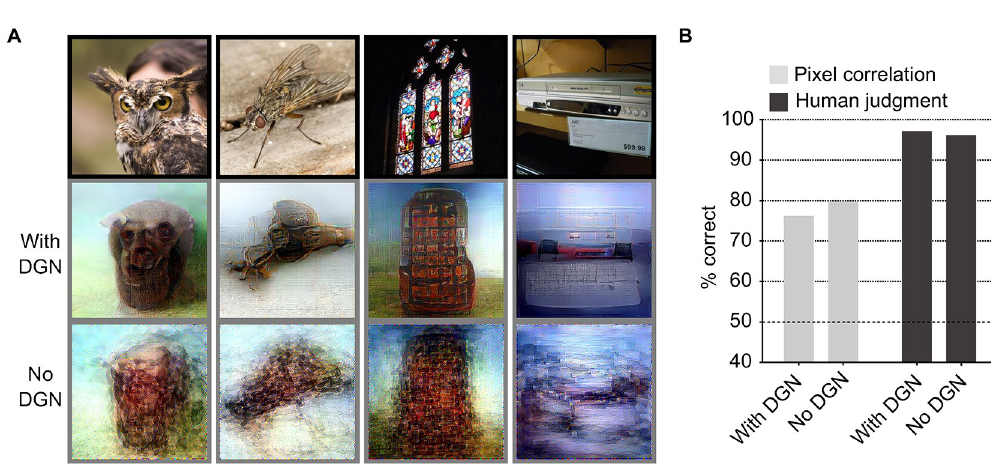
Fig 3. Effect of the deep generator network (DGN). ( A ) Reconstructions with and without the DGN. The first, second, and third rows show presented images, and reconstructions with and without the DGN respectively (reconstructed from VC activity, DNN1–8). ( B ) Reconstruction quality of seen natural images (three subjects pooled, N = 150; chance level, 50%).